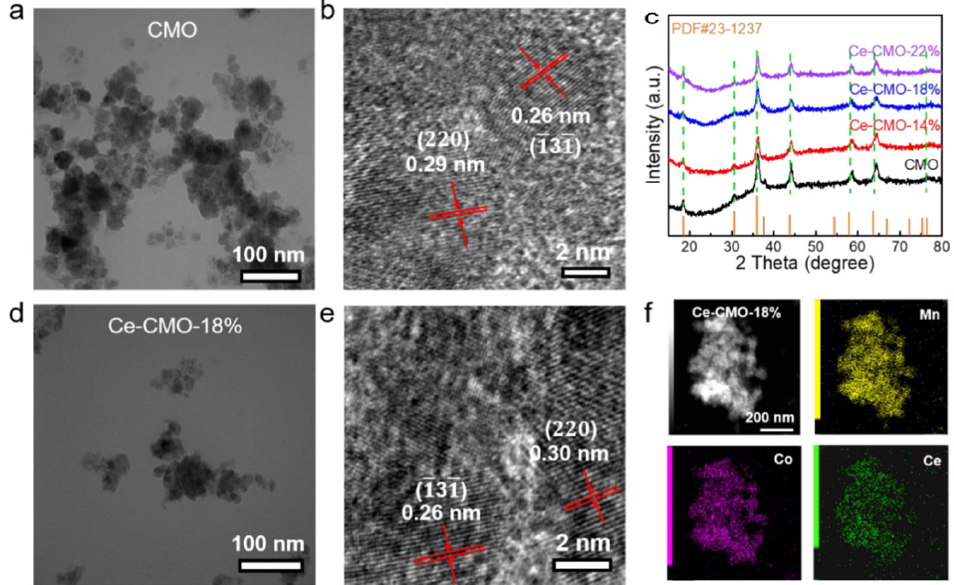
Figure 1. The characterization of catalysts: ( a ) TEM image and ( b ) HRTEM image of CMO nano- particles; ( c ) XRD patterns of CMO nanoparticles and various Ce-CMO-X nanoparticles; ( d ) TEM image and ( e ) HRTEM image of Ce-CMO-18%; ( f ) HAADF-STEM image and the corresponding EDS mapping of Ce-CMO-18%.